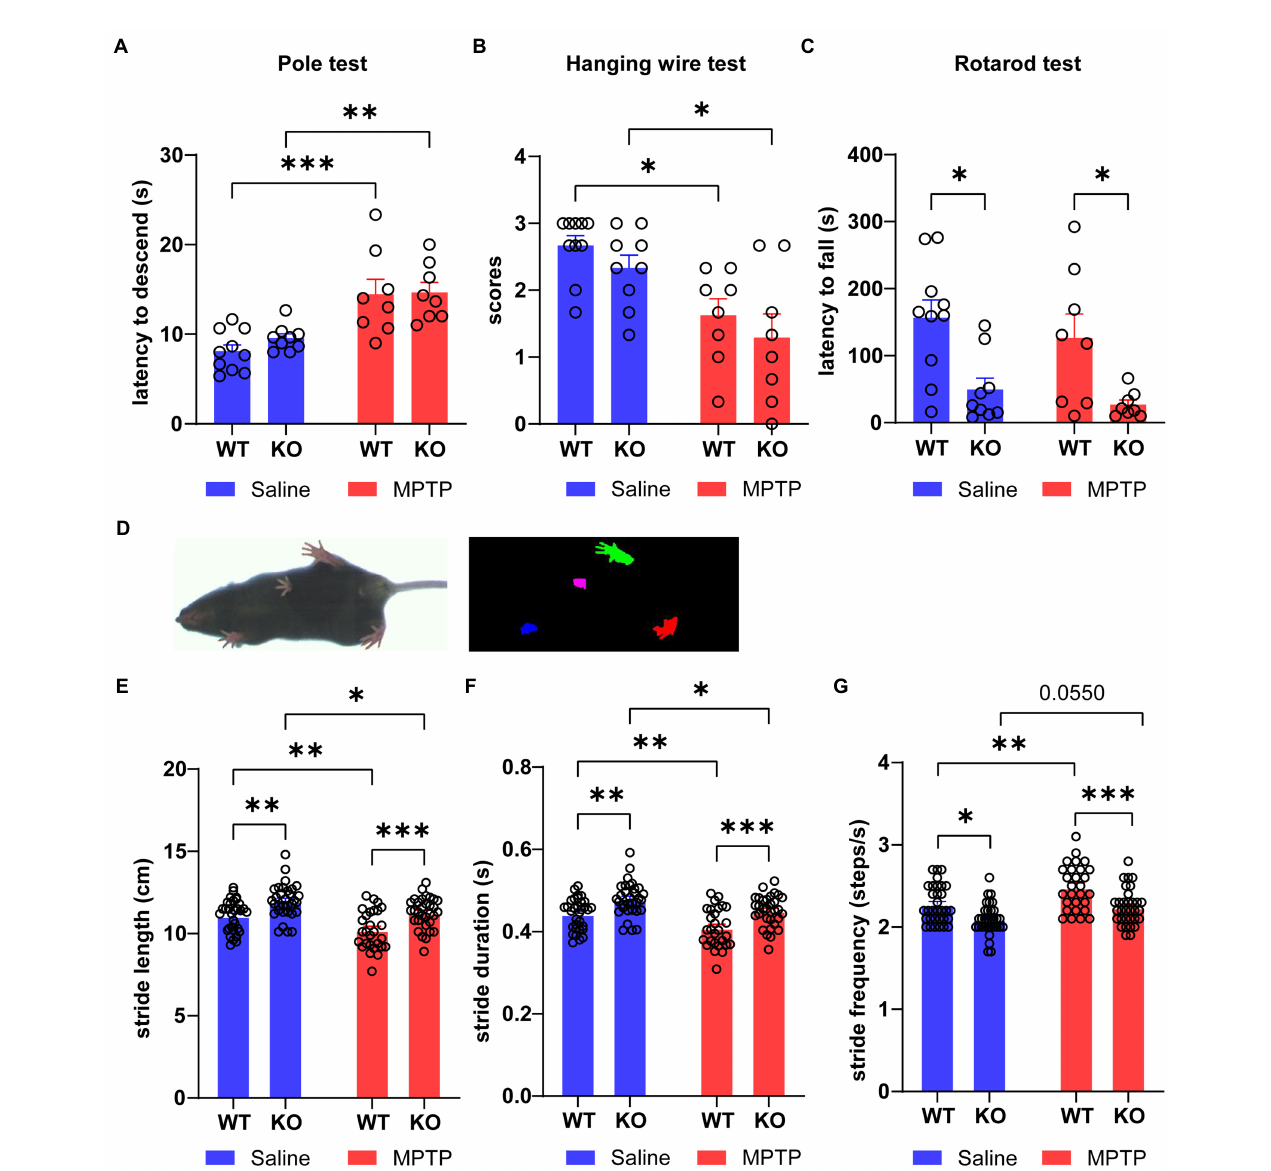
FIGURE 2 Loss of Rab39b does not alter motor behavior impairment in MPTP-induced mice. (A) Latency of descending from the top to the bottom in MPTP-treated Rab39b KO and WT mice or respective saline-treated control mice was recorded in pole test for comparison. n = 10 for Saline-WT, n = 9 for Saline-KO, and n = 8 for both MPTP-WT and MPTP-KO. (B) Hanging wire test was performed in MPTP-treated Rab39b KO and WT mice or respective saline-treated control mice and the scores were calculated for comparison. n = 10 for Saline-WT, n = 9 for Saline-KO, and n = 8 for both MPTP-WT and MPTP-KO. (C) MPTP-treated Rab39b KO and WT mice or respective saline-treated control mice were subjected to the rotarod test and the average latency to fall was calculated for comparison. n = 10 for Saline-WT, n = 9 for Saline-KO, and n = 8 for both MPTP-WT and MPTP-KO. (D) Representative image of a mouse subjected to video recording of gait analysis (left) and digital image of the ventral surface of the gait footprints during the analysis (right). (E-G) The stride length, stride duration, and stride frequency in MPTP-treated Rab39b KO and WT mice or respective saline-treated control mice. n = 32 paws from 8 mice for Saline-WT, Saline-KO and MPTP-KO, and n = 28 paws from 7 mice for MPTP-WT. Data represent mean ± SEM, * p < 0.05, ** p < 0.01, *** p < 0.001, two-way ANOVA followed by Tukey’s post hoc